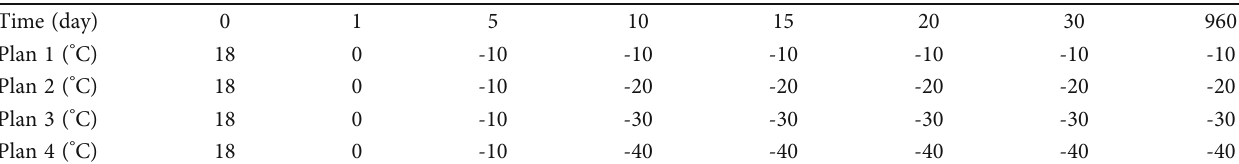
Table 4: Di ff erent brine cooling schedules.